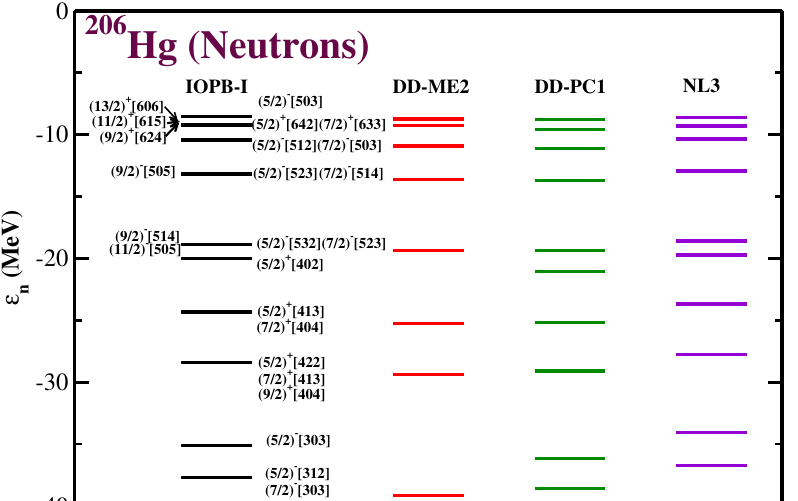
Figure 8. (Color online) The ground state neutron single particle energies (cid:101) n of 206 Hg near the Fermi level with IOPB-I, DD-ME2, DD-PC1 and NL3 parameter sets.